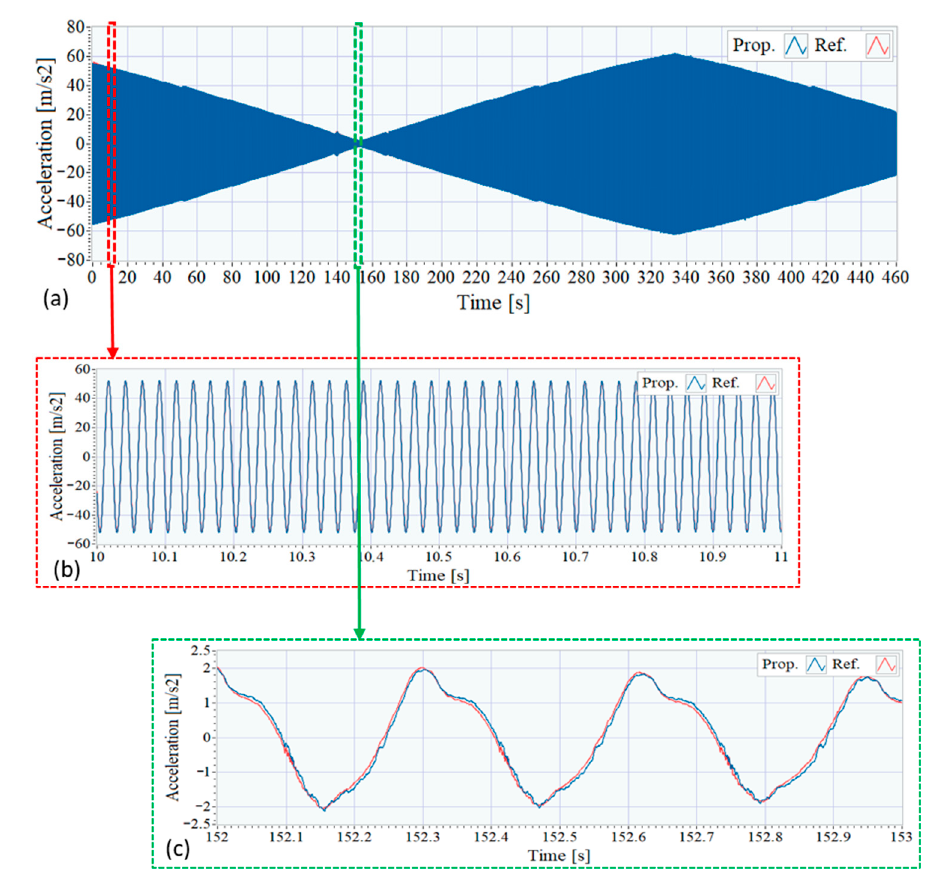
Figure 8. Time signals of accelerometers at the excitation sensors position. ( a ) Full signal. ( b ) Zoom between 10 and 11 s. ( c ) Zoom between 152 and 153 s.